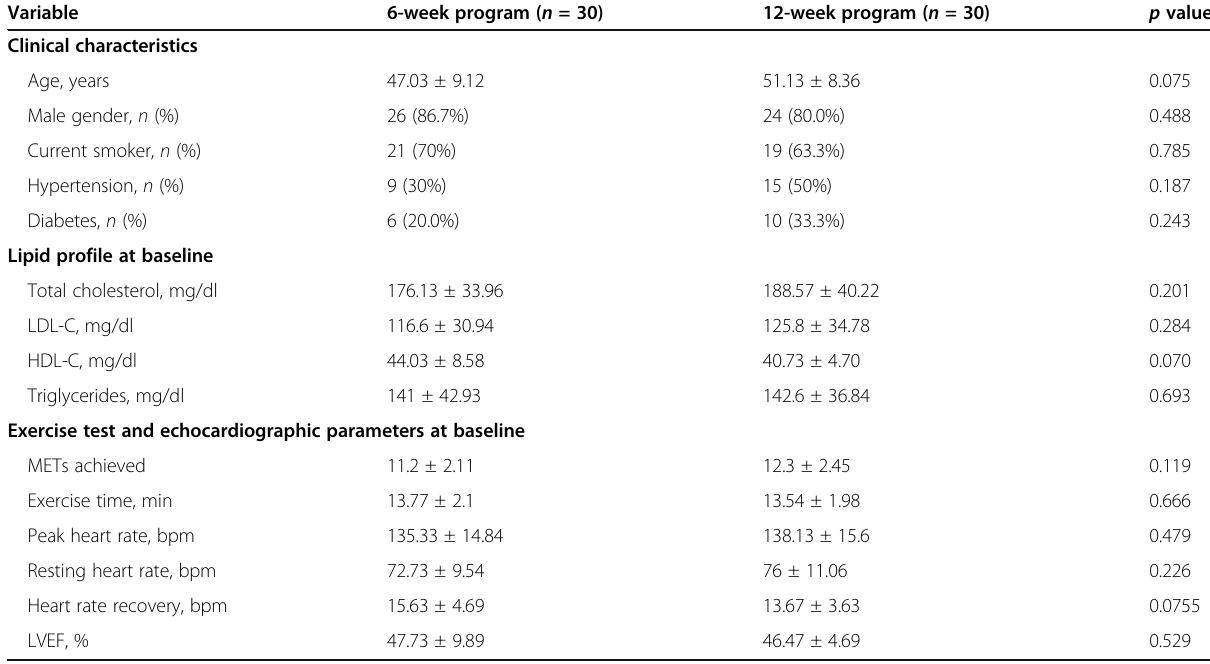
Table 1 Comparing baseline